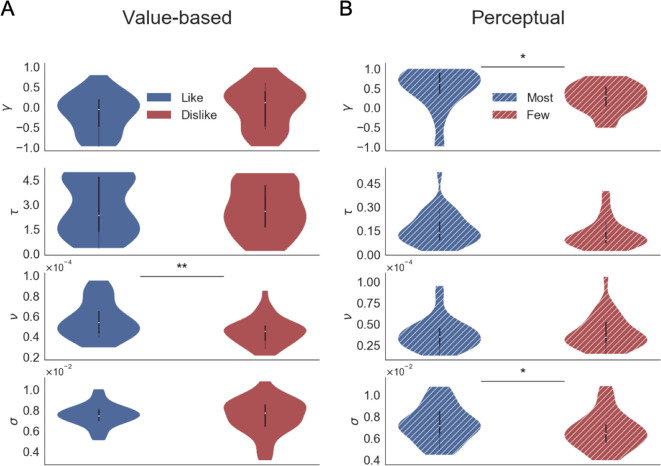
Parameters fitted at subject level using GLAM in Value (A) and Perceptual (B) Experiments.The free parameters are γ (gaze bias), τ (evidence scaling), ν (drift term), and σ (standard deviation of the normally distributed noise). In the Value Experiment, we found a significant decrease in the drift term during the dislike frame, maybe indicating a more uncertain decision process. The parameters in Perceptual Experiment were significantly different for gaze bias and noise term, with higher γ and σ values in the most frame. This may indicate a reduced effect of gaze on choice during the most frame and slightly less noisier accumulation process in the fewest frame. In each experiment, the GLAM parameters were fitted independently for each frame. In the violin plot, red and blue areas indicate the distribution of the parameters across participants. Black bars present the 25, 50, and 75 percentiles of the data. Solid colour indicates the Value Experiment and striped colours indicate the Perceptual Experiment.